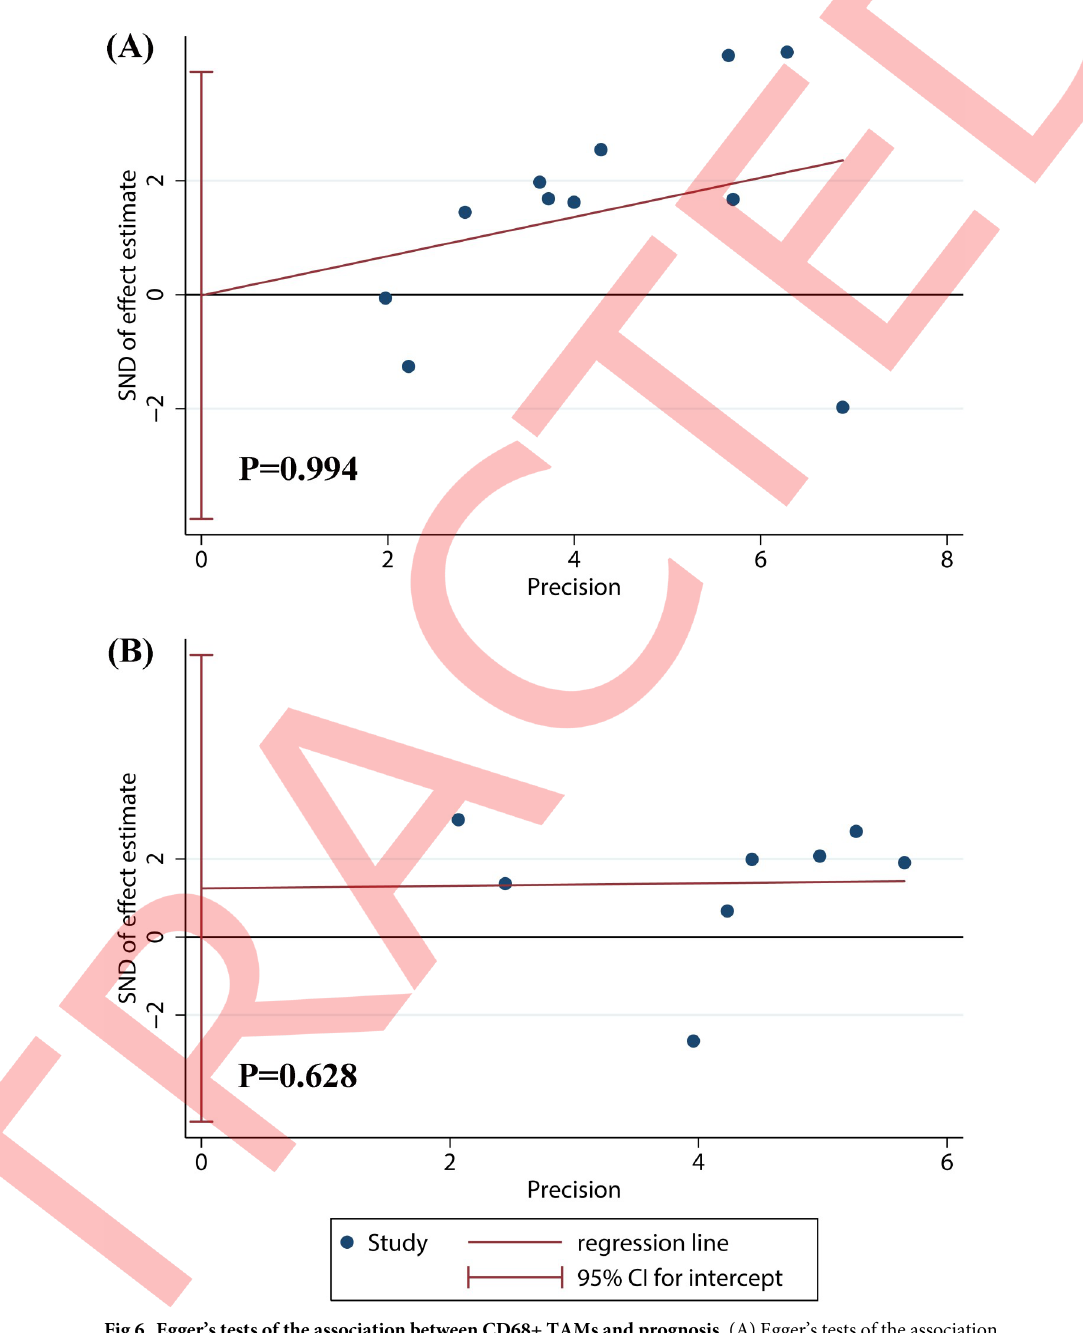
Fig 6. Egger’s tests of the association between CD68+ TAMs and prognosis. (A) Egger’s tests of the association between CD8+ TAMs in IT and OS; (B) Egger’s tests of the association between CD68+ TAMs in PT and OS.